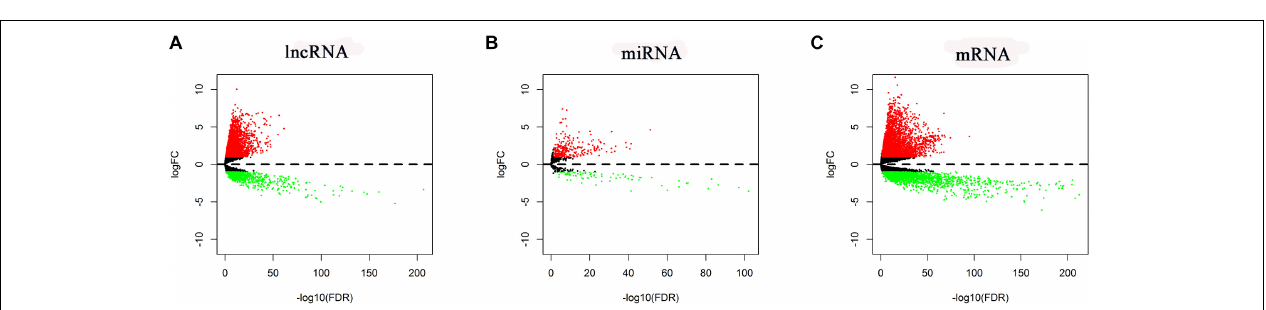
FIGURE 1 | Flow chart for identifying and assessing the survival-related LncRNA-based signature.